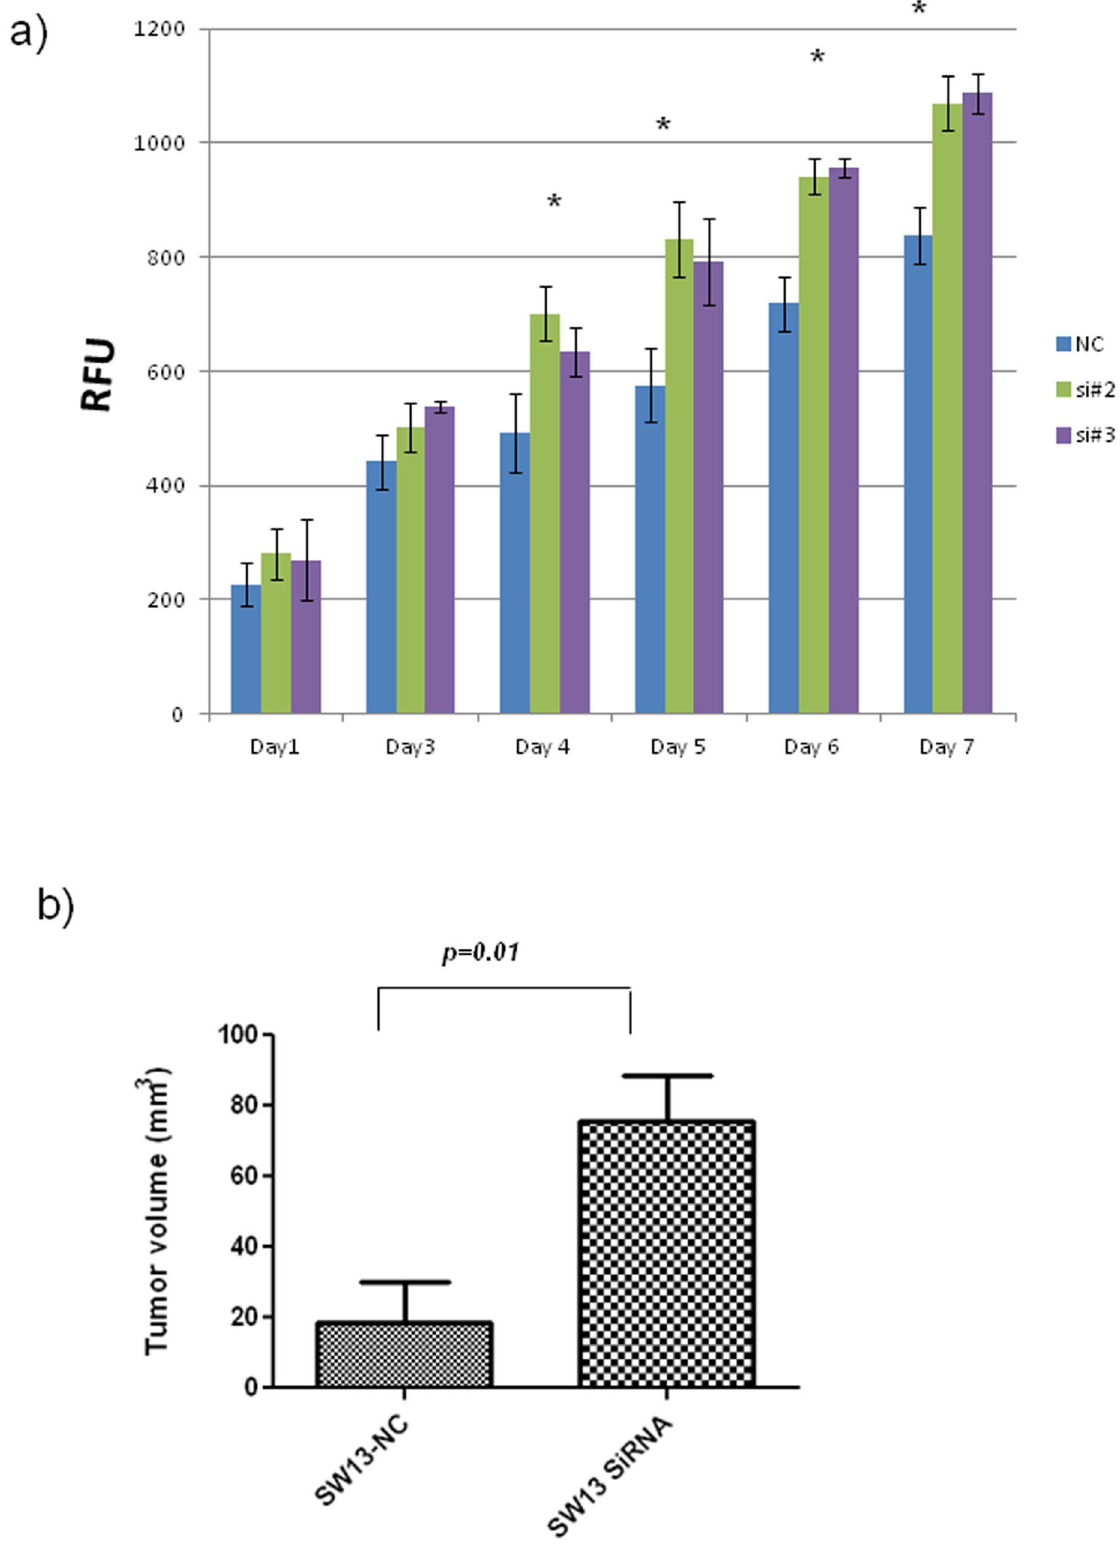
Figure 2. The effect of ZNF367 knockdown on growth in SW13 cells in vitro and in vivo. (A) ZNF367 knockdown increases cellular proliferation. The Y axis represents relative fluorescent units (RFU), and the X axis indicates days post-transfection. *p , 0.05 relative to the negative control. Error bars represent 6 SD. (B) ZNF367 knockdown enhances tumor growth in vivo. SW13 cells were transfected with the negative control (n=4) and siRNA (n=4) into the right and left flank of each mouse. After 48 hours of transfection, 3 6 10 6 cells were injected in athymic nude mice,